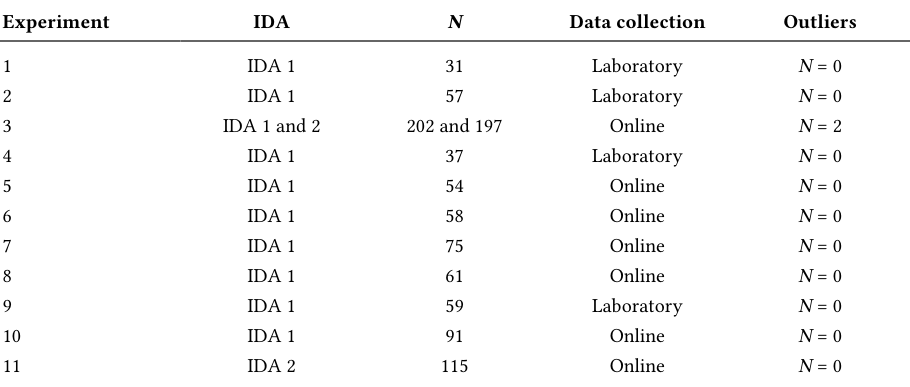
Overview of the Eleven Experiments Included in the Two Integrative Data Analyses (IDAs)